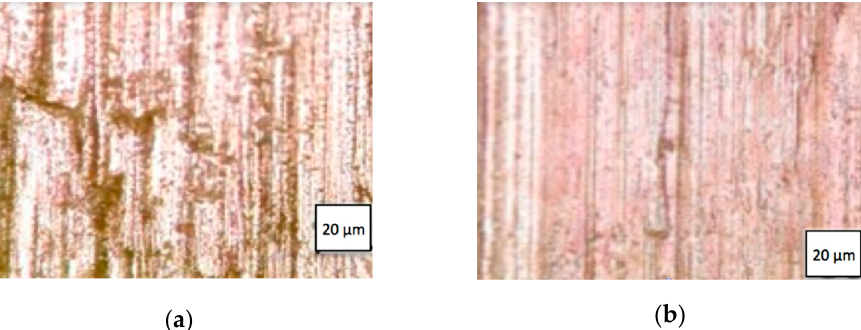
Figure 5. Quality of the TiC/Fe composite surface machined with different inserts: ( a ) BK6; ( b ) WolCar. ( b )